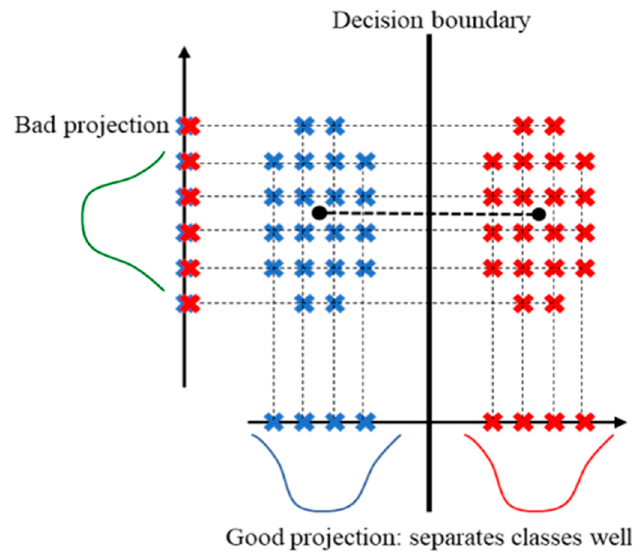
Figure 9. Procedure of the discriminant analysis method from an input sample.